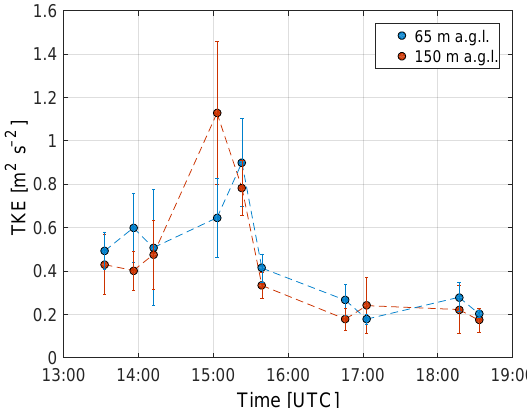
Figure 11. Evolution of TKE from 15 June at Site 2. The colors indicate the different altitudes of 65 (blue) and 150 (red)ma.g.l. Mean TKE over all legs is shown by the circles. The vertical bars show the variation between individual legs. The flight times are all in UTC, and represent the start of each